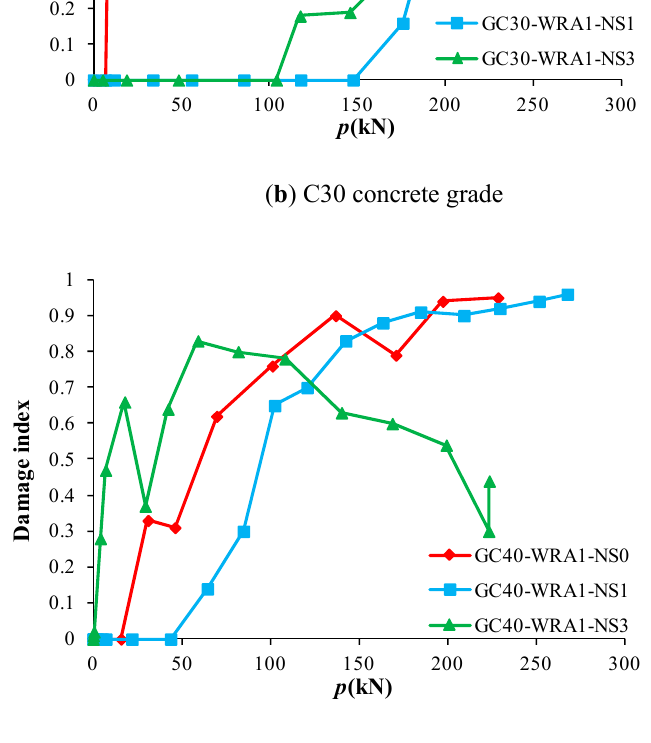
Figure 15. Index curves of specimens with different nano-SiO 2 contents.